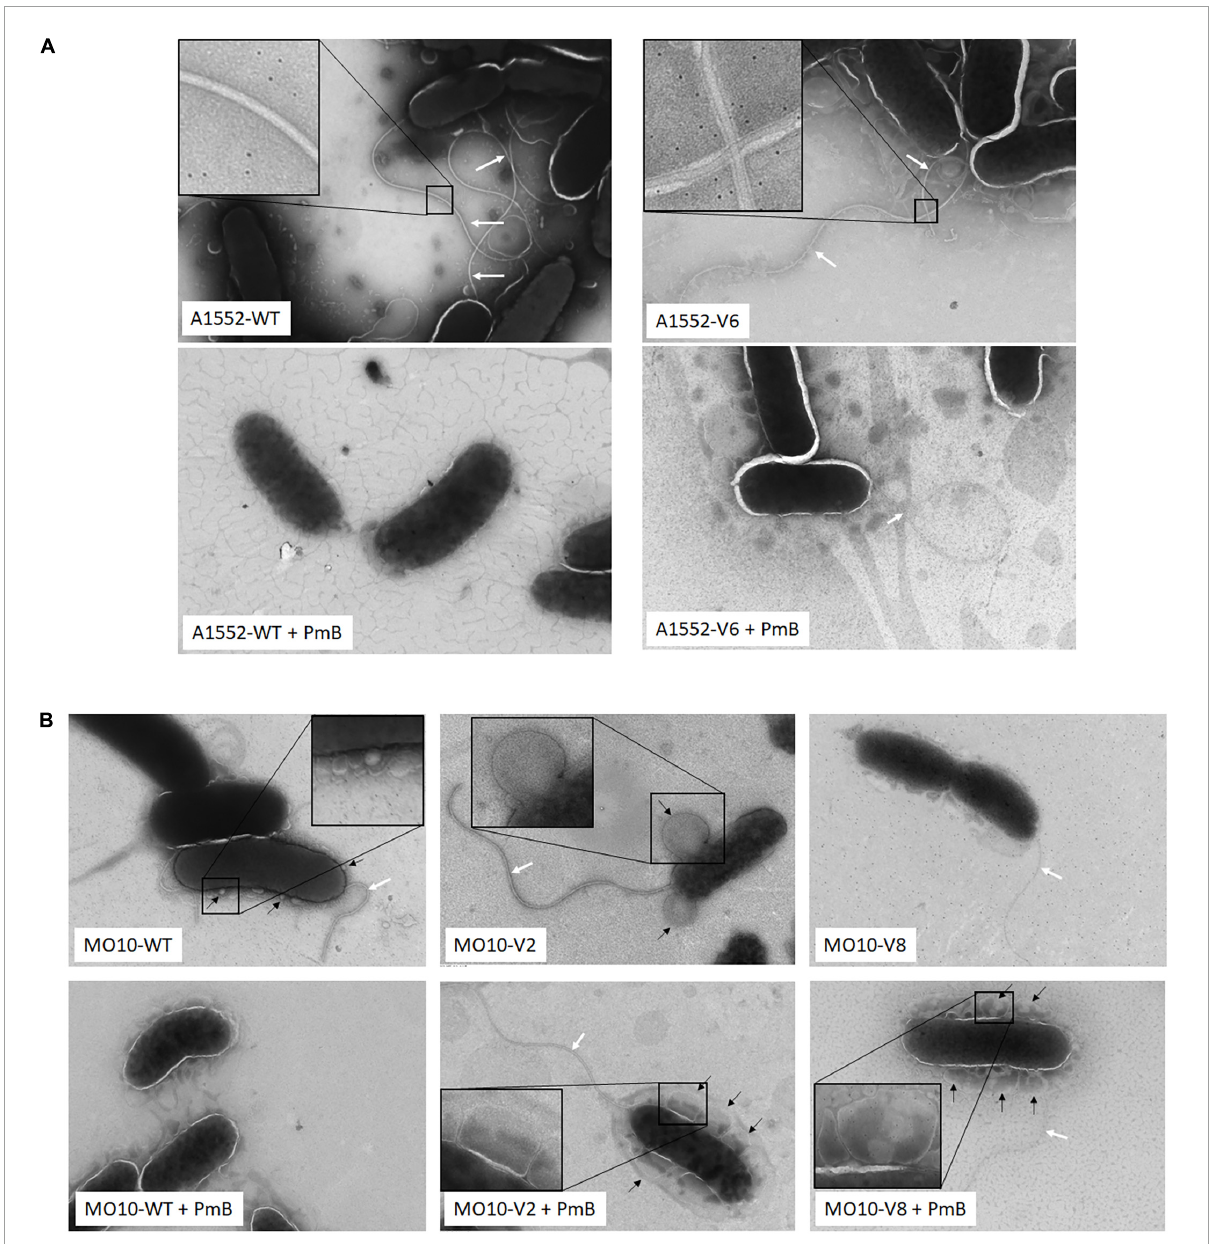
FIGURE6 Electron microscopy images. (A) A1552-WT and A1552-V6 and (B) MO10-WT, MO10-V2, and MO10-V6. Bacteria were grown to an exponential phase in the absence and the presence of PmB (+ PmB). White arrows indicate the bacterial flagellum and black arrows indicate membrane